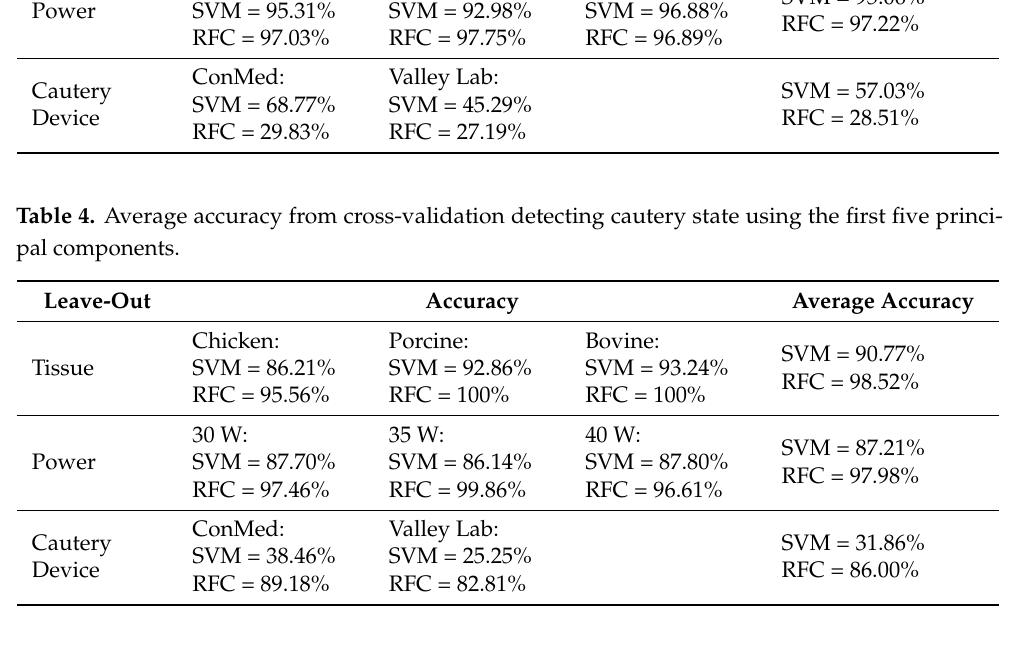
Table 5. Average accuracy detecting the energy level for each cautery using maximal intensity and corresponding